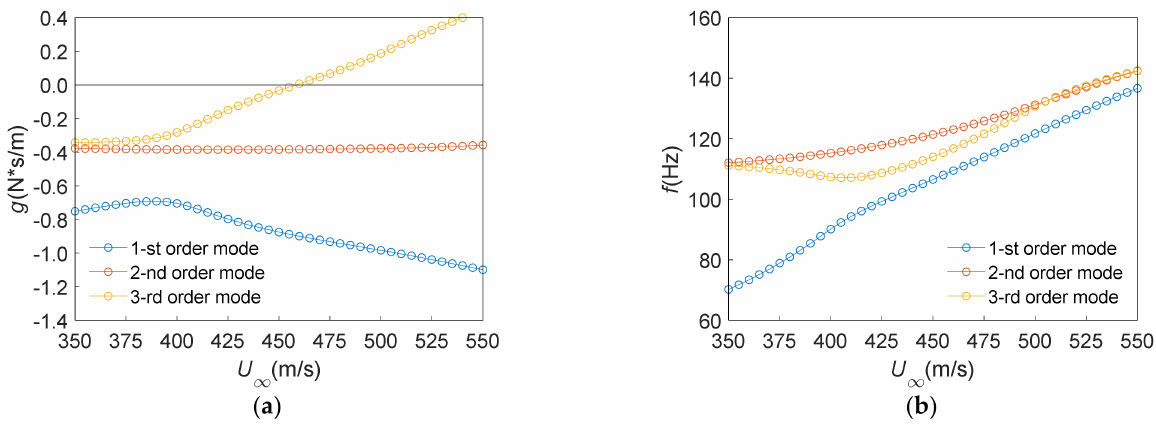
Figure 14. Results of flutter calculation under 5P method (L4): ( a ) U − g ; ( b ) U − f .